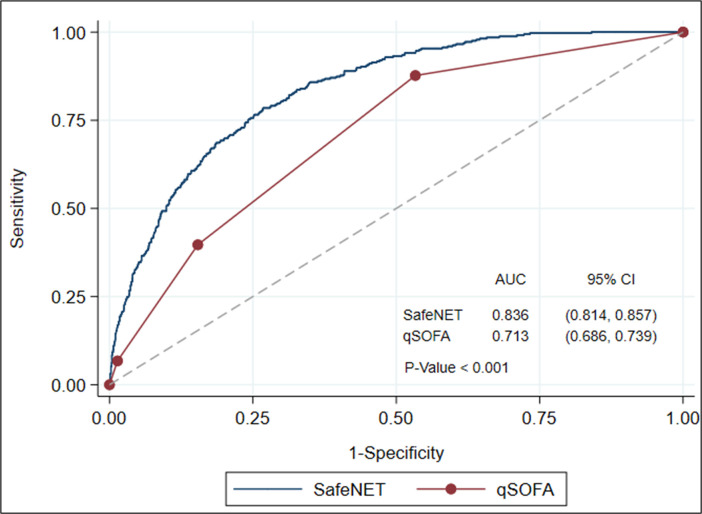
Comparison of receiver operating characteristic (ROC) curves for SafeNET and qSOFA.The ROC curves and discrimination of the SafeNET (Safe Nonelective Emergent Transfers) and qSOFA (quick Sequential Organ Failure Assessment) models are displayed.